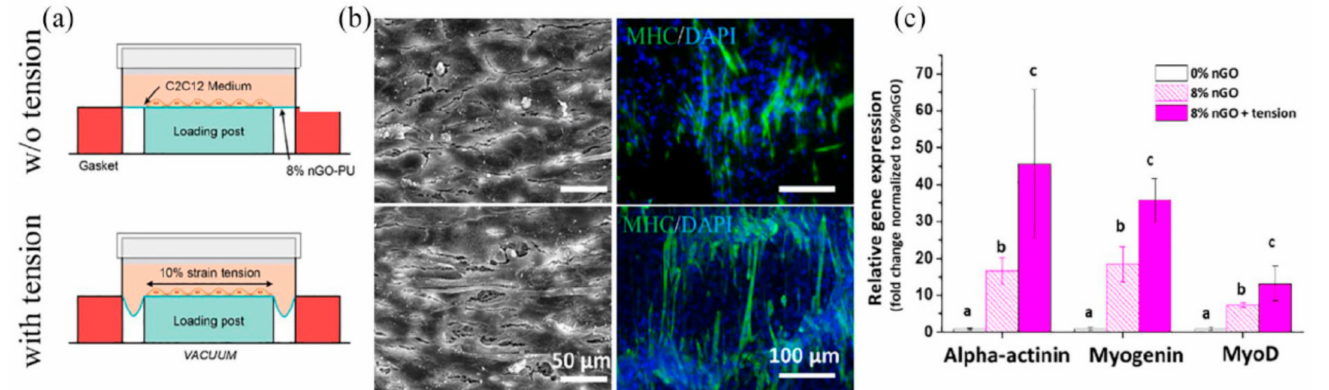
Figure 10. PU-nGO nanofiber synergizes with dynamic mechanical tension in myogenic differenti- ation. After 3 days of differentiation on 8% PU-nGO nanofiber under dynamic tension force using Flexcell machine (10% strain, 0.5 Hz, 1 h/day), ( a ) SEM, ( b ) immunocytochemistry of myosin heavy chain (MHC) images were taken. Fully covered C2C12 cells on 8% PU-nGO nanocomposite were observed by SEM. MHC expression and aligned myotubular formation were highly up-regulated in 8% PU-nGO under dynamic tension compared to static incubation. Dynamic tension and nGO worked in synergy to enhance the myogenesis of C2C12 cells. ( c ) Myogenic gene expression results (alpha-actinin, myogenin, and MyoD). Dynamic tension enhanced myogenic gene expression syner- gistically with nGO. Different letters indicating significant differences among them ( p < 0.05, n = 4). Data reproduced with permission from Ref.